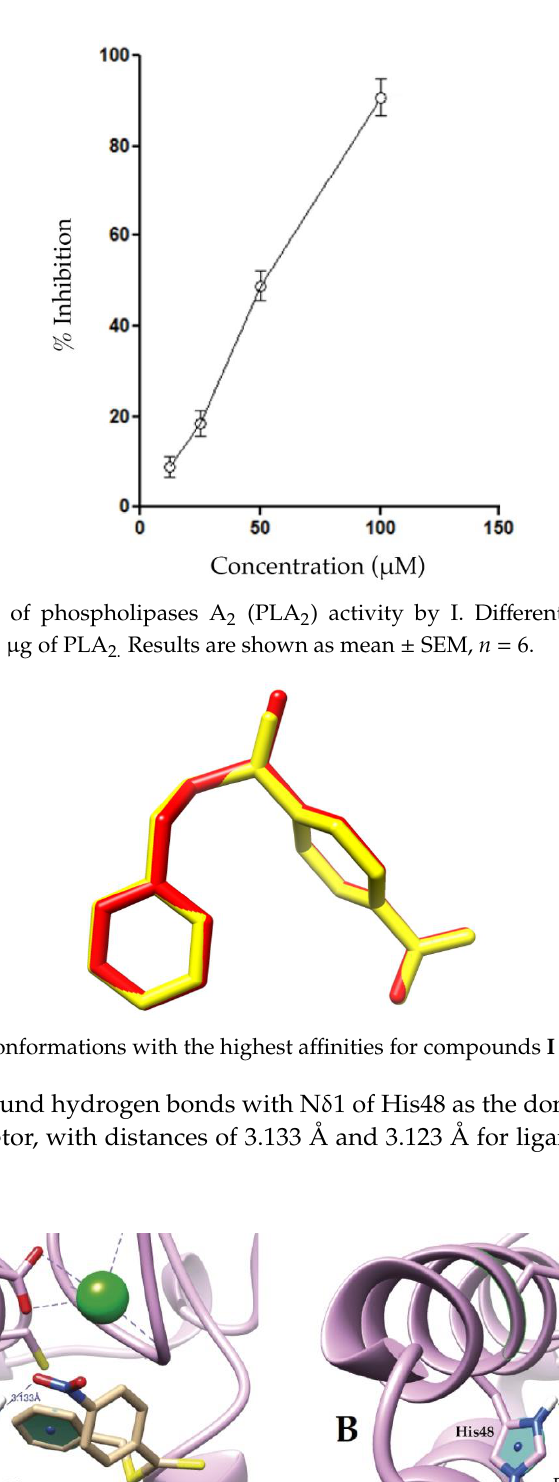
Figure 4. Hydrogen bond PLA 2 with compounds I ( A ), II ( B ).